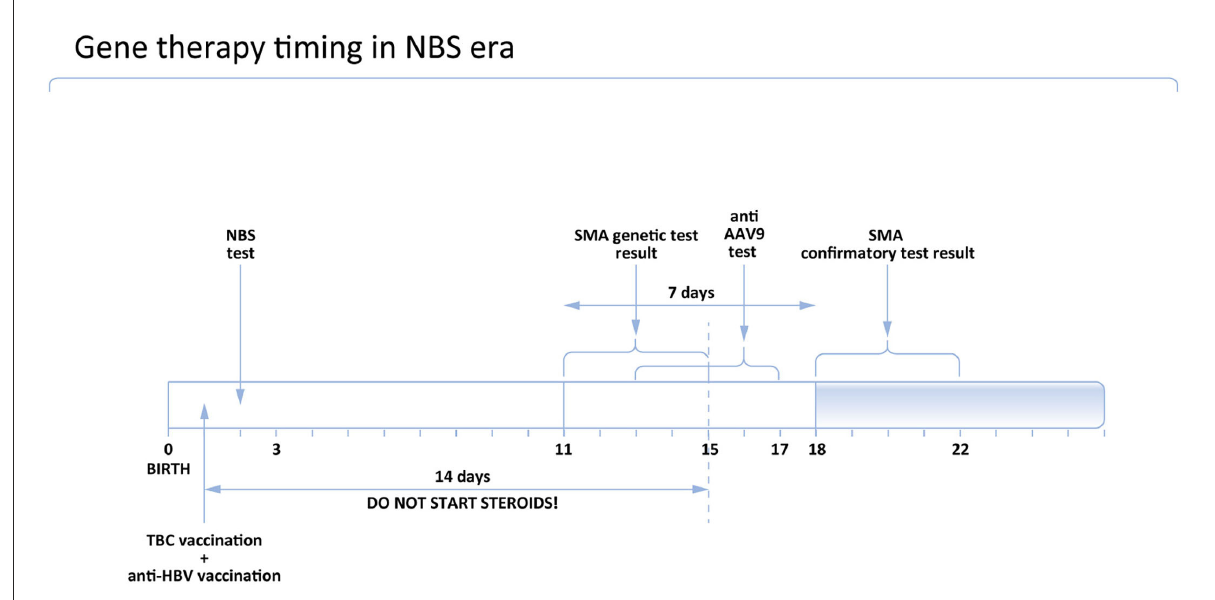
FIGURE1 Proposed timing of gene therapy in Poland in the NBS